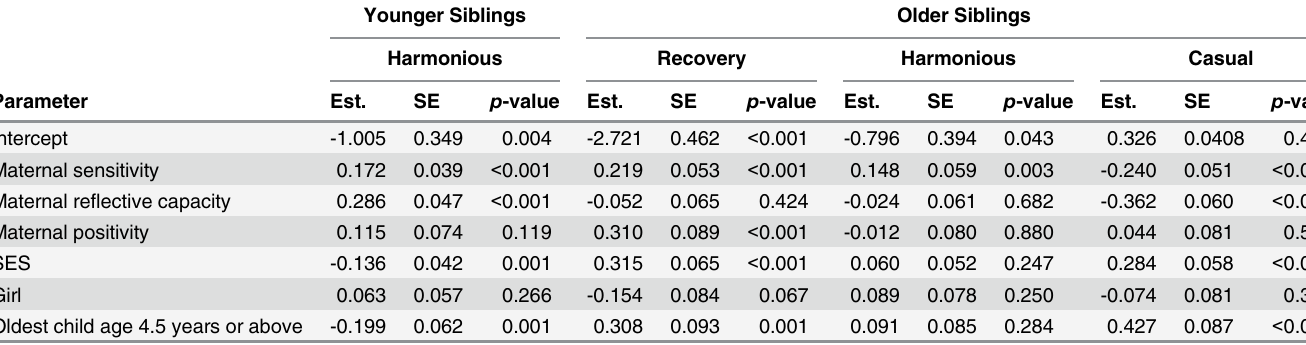
Table 3. Covariate Effects on Class Membership for Younger and Older